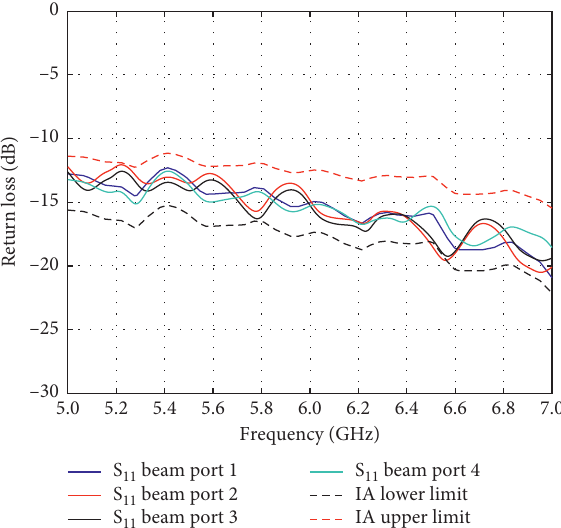
Figure 11: C-band Rotman lens: return loss at the beam ports.